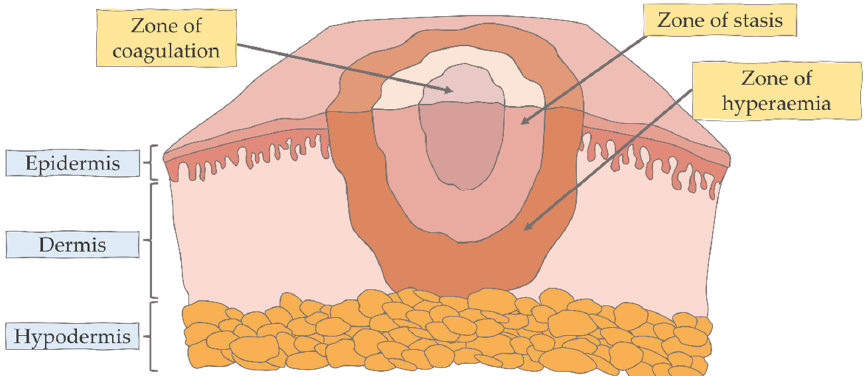
Figure 2. Jackson’s three zones in